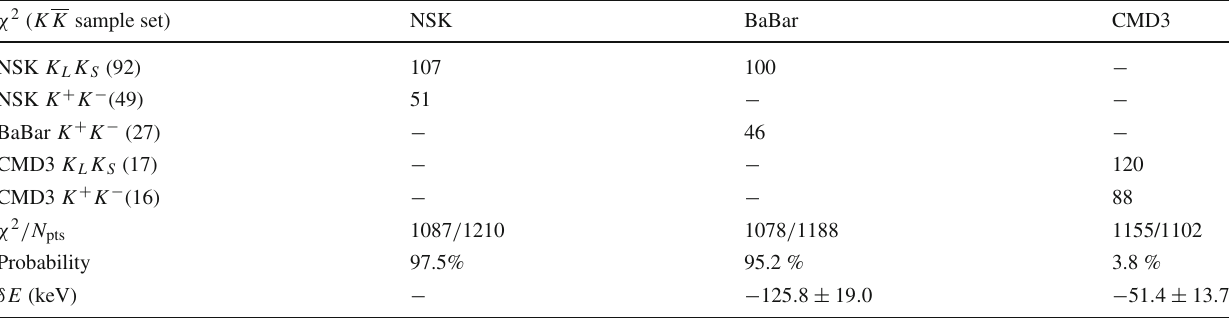
Table 1 BHLS 2 fit properties in the kaon sectors. The kaon data from NSK, BaBar and CMD-3 are fitted in isolation. Running BaBar data “alone” is complemented by the NSK data for the K L K S channel. The data and channels other than kaon are identical in all cases; the full χ 2